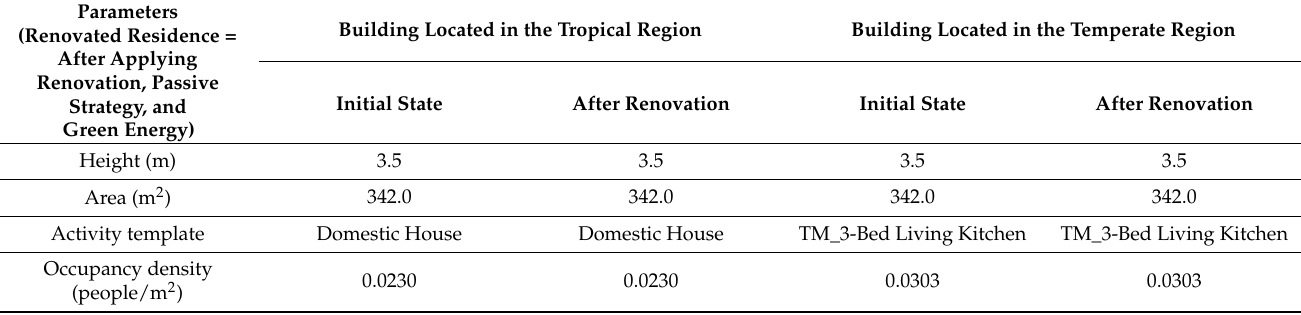
Table 5. Input data for the